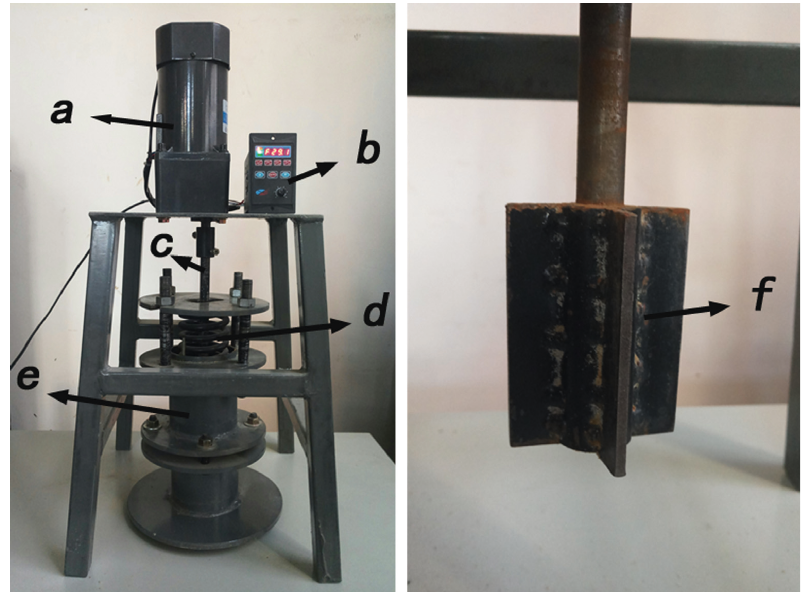
Figure 1: Homemade vane shear device (a: geared motor; b: frequency converter; c: shaft; d: compression spring; e: pressure chamber; f: shear vane).